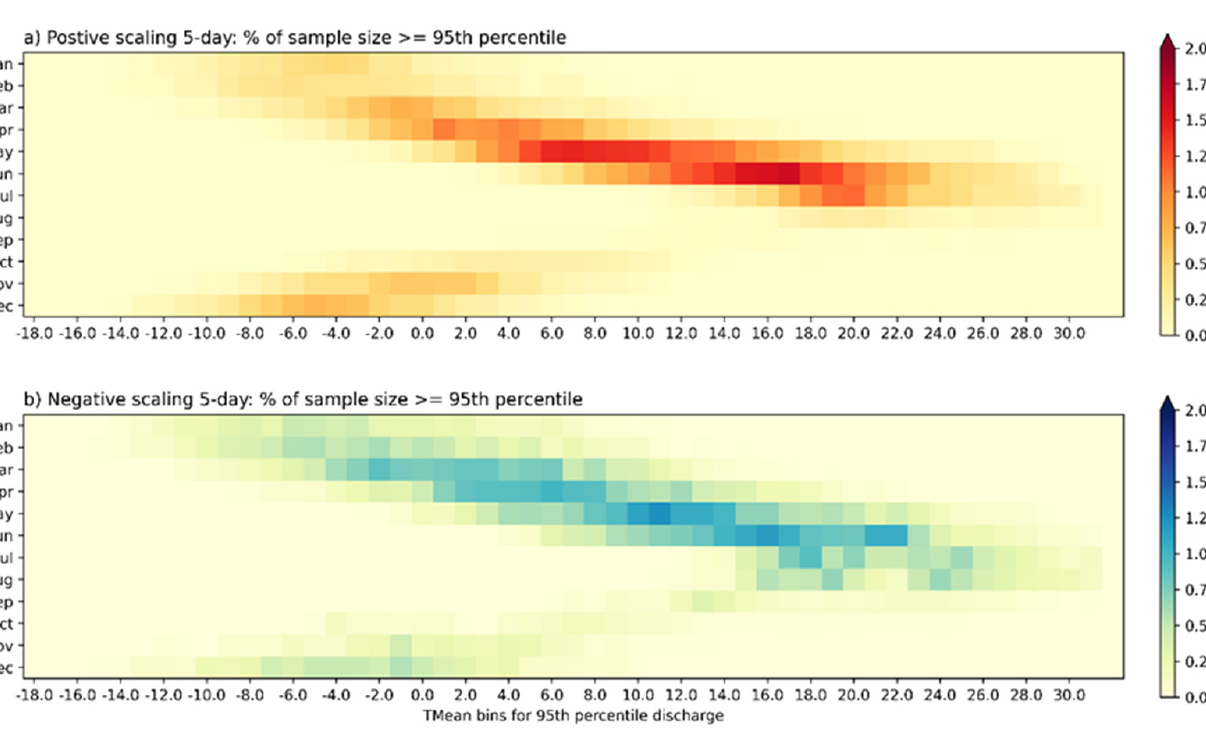
Figure A4. As in Figure 6 except scaling with 5-day running mean temperature.